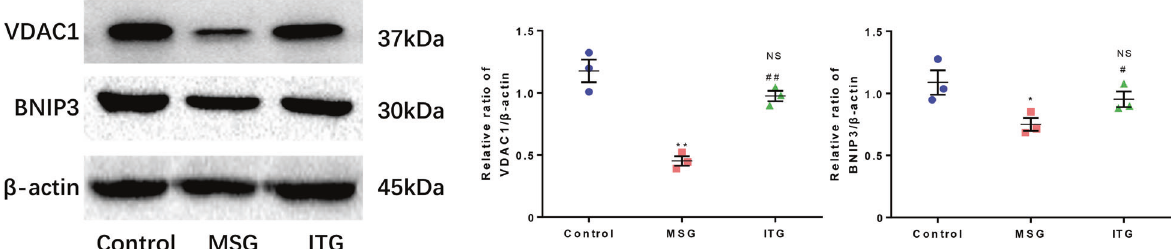
Fig. 5 Effect of idebenone on mitochondrial membrane proteins VDAC1 and BNIP3. a Protein immunoblotting of the VDAC1 and BNIP3 levels in the mouse midbrain substantia nigra. b Statistics of VDAC1 protein levels in the substantia nigra of mice. c Statistical analysis of the BNIP3 protein level in the mouse midbrain substantia nigra * P < 0.05, ** P < 0.01, NS not signi fi cant vs. control, # P < 0.05, ## P < 0.01 vs. MSG, N = 3.